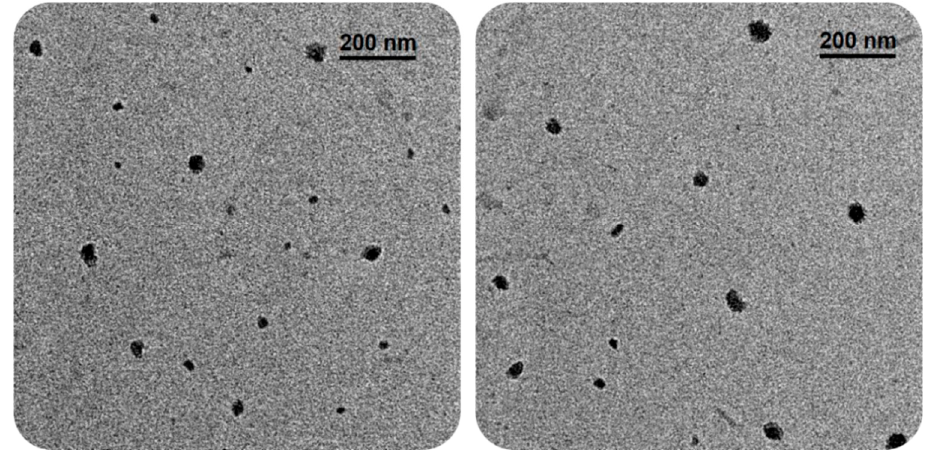
Figure 10. TEM images show spherical and cylindrical particles and sizes less than 100 nm.